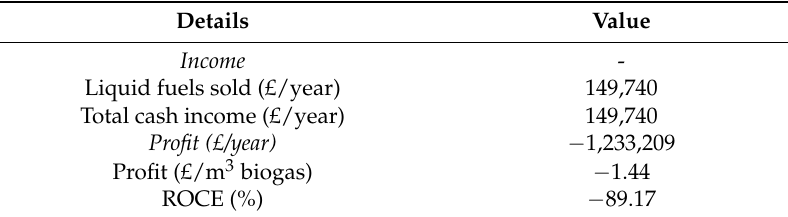
Table A2. Income, profit and ROCE for the reforming of biogas for the production of liquid fuels via FT (routes T1/H1).